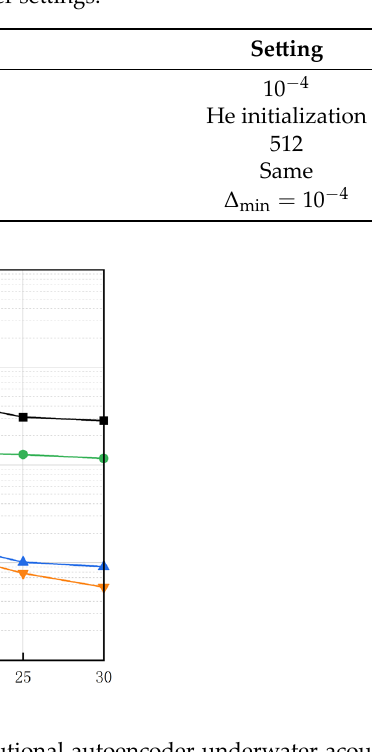
Figure 6. BER performance of dense convolutional autoencoder underwater acoustic communica- tions compared with the traditional